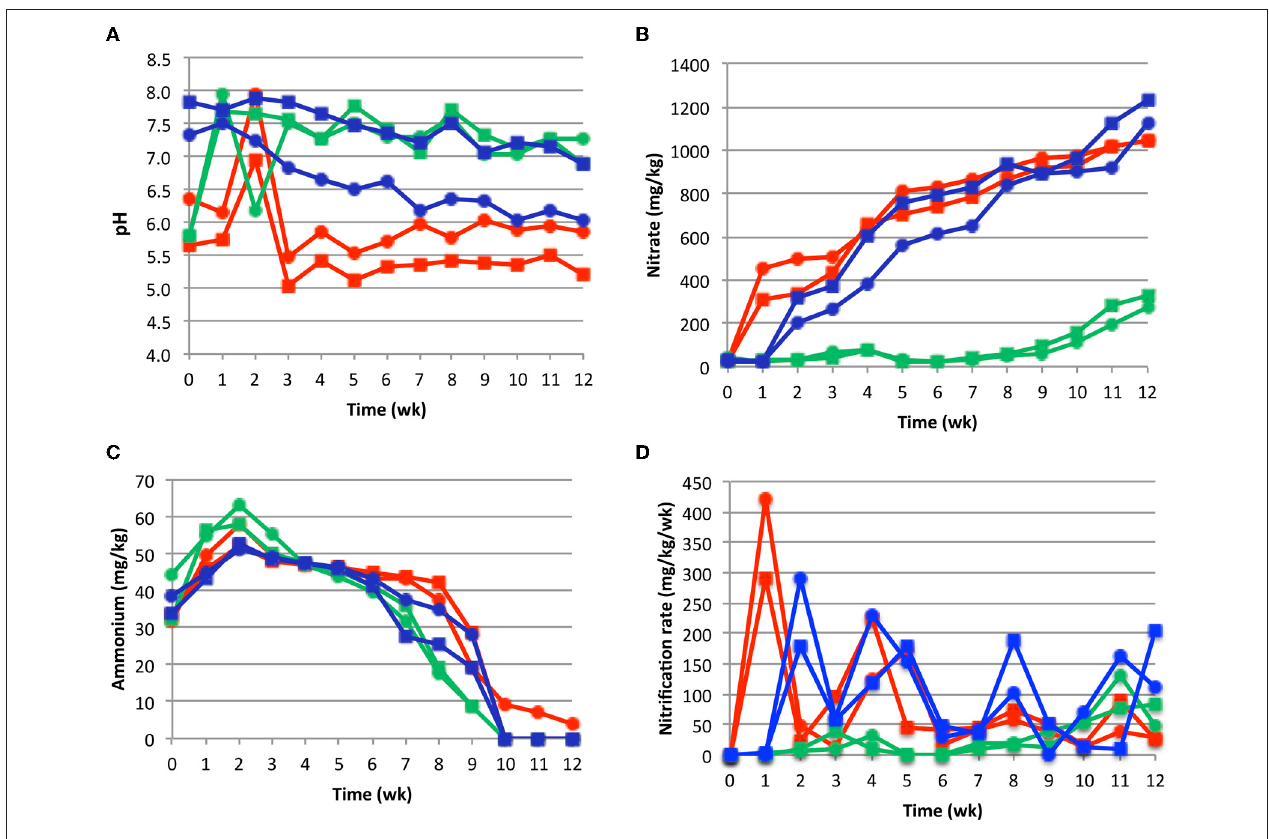
FIGURE 2 | Compost physiochemical dynamics. Panel A , pH; Panel B , nitrate concentration; Panel C , ammonium concentration; Panel D , apparent nitrification rate. The latter was calculated as the